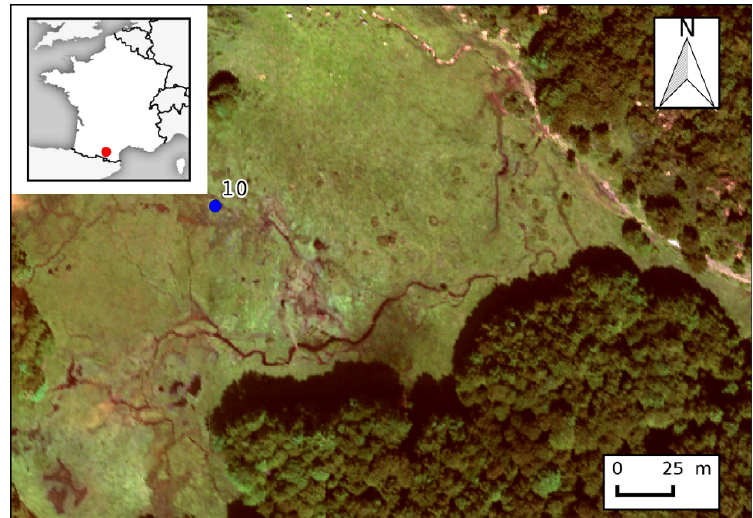
Figure A7. Location of the in situ spectroradiometer measurements for the plots of Pinguicula sp. (PING). Table A5. Pictures, plots, geographic coordinates and number of spectra of Pinguicula sp. (PING). Picture